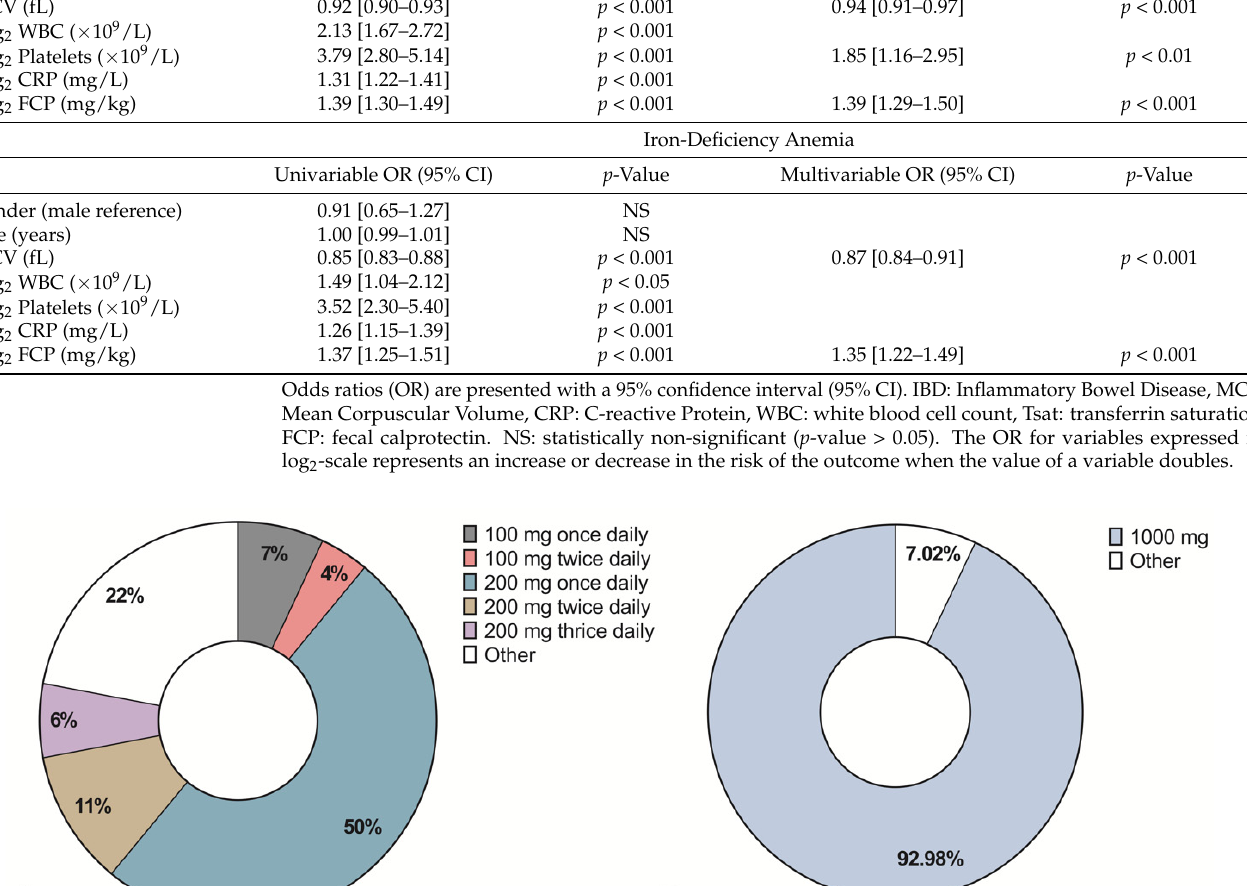
Table 4. Differences between patients with Inflammatory Bowel Disease who received iron therapy and those who did not. Received Iron Therapy ( n = 204)